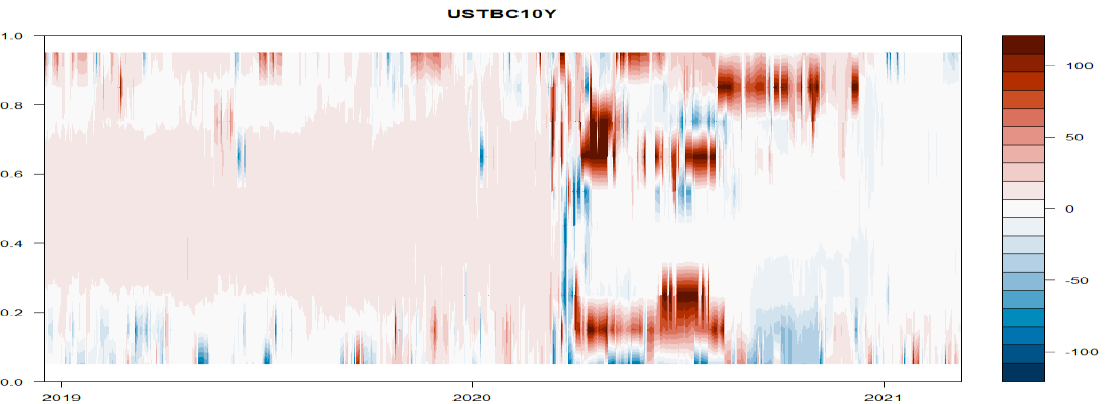
Figure 7. Results for net total directional connectedness for the S&P US Treasury Bond 10YR Index based on a 200-day rolling-window QVAR(1) model and a 20-step-ahead forecast.